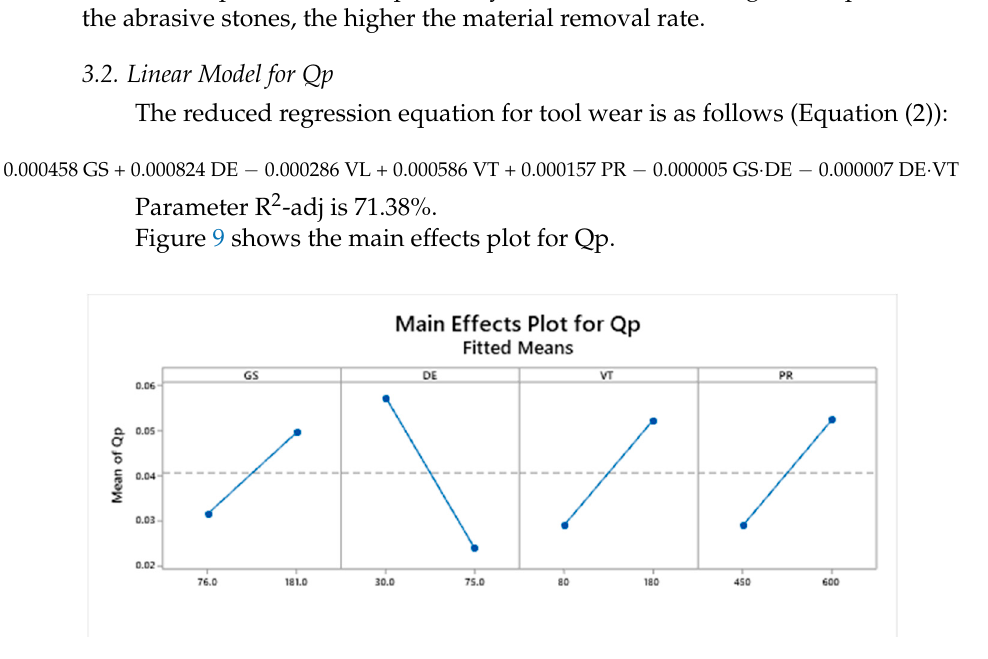
Figure 11. Pareto chart of the standardized effects for tool wear Qp.